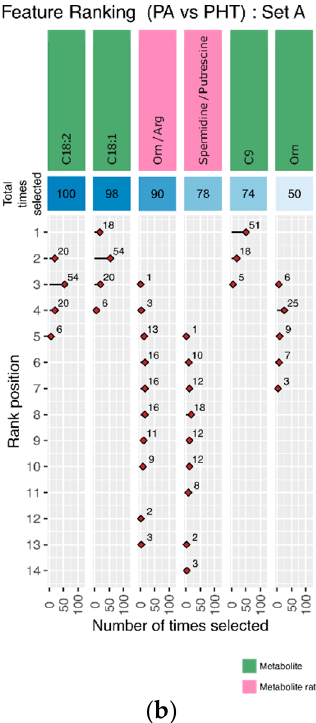
Figure A4. ( a ) Heatmap showing the number of times a feature (metabolites or its ratios) was selected for PA vs PHT disease comparison in different sets (A–F); ( b ) Feature ranking for Set A in PA vs PHT disease comparison.